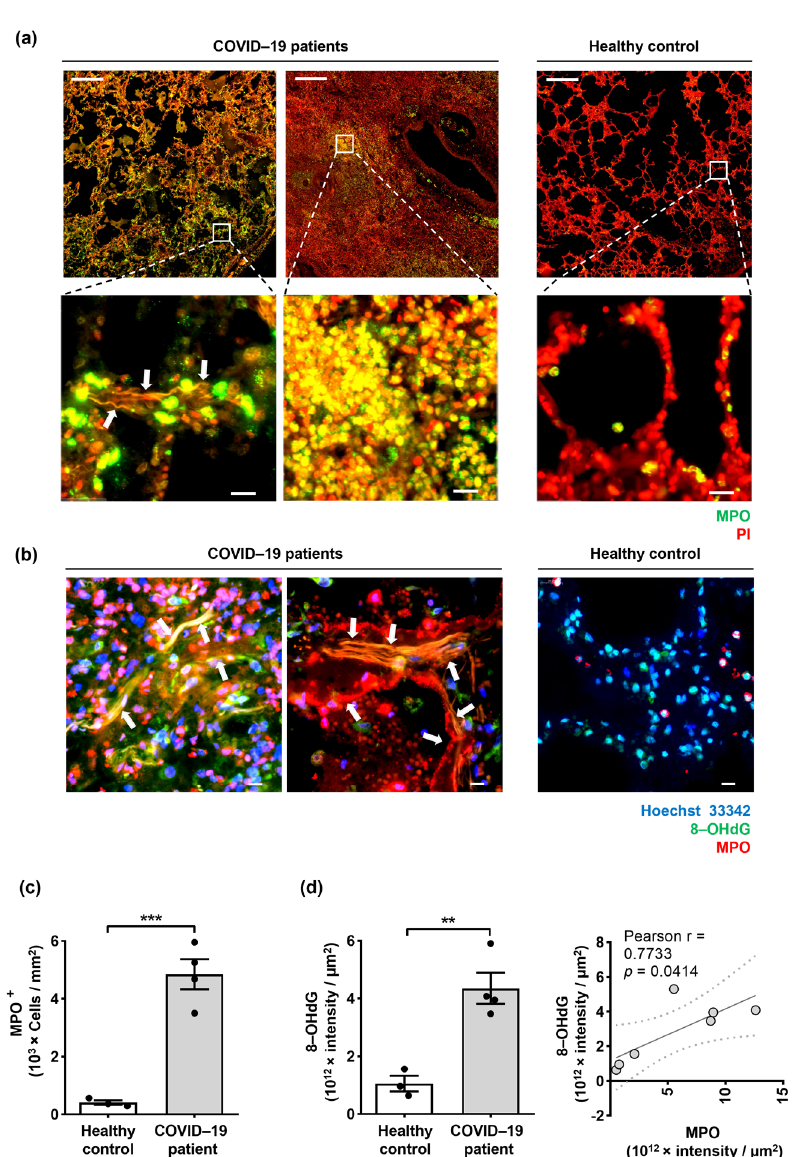
Figure 3. Neutrophil extracellular traps (NETs) in the lungs of COVID–19 patients are associated with oxidized dsDNA. ( a ) Lung tissues of COVID–19 patients ( n = 4) and control donors ( n = 3) were stained with anti-MPO antibody (green) and PI (propidium iodide, red) to detect NETs. Scale bars, 500 μ m. Representative original data are shown. Lower panels: higher magnifications are shown with white arrows indicating the co-localization of extracellular DNA and MPO. Scale bars, 20 μ m. Representative original data are shown. ( b ) Confocal microscopy of NETs is depicted with anti-MPO antibody (red), anti-8–OHdG antibody (green), and counterstained with Hoechst 33342 (blue) (colocalization is shown with white arrows). Scale bars, 10 µ m. Representative original data are shown. ( c ) Neutrophil quantification in lung tissue of COVID–19 patients ( n = 4) and control donors ( n = 3) using an automatic digital slide scanner (Panoramic MIDI II, 3DHistech, Budapest, Hungary) is shown as cells/mm 2 . ( d ) Quantification of fluorescence intensity sums of MPO and 8–OHdG was performed for each tissue section using Imaris software, version 9.9.1 (Oxford Instruments, Zurich, Switzerland) as intensity sum/ μ m 2 . The right panel shows the correlation between the intensity of MPO and 8–OHdG in the lungs of COVID–19 patients ( n = 4) and control donors ( n = 3). Values are means ± SEM. Single data are presented in scatter dot plots. ** p < 0.01; *** p < 0.001.